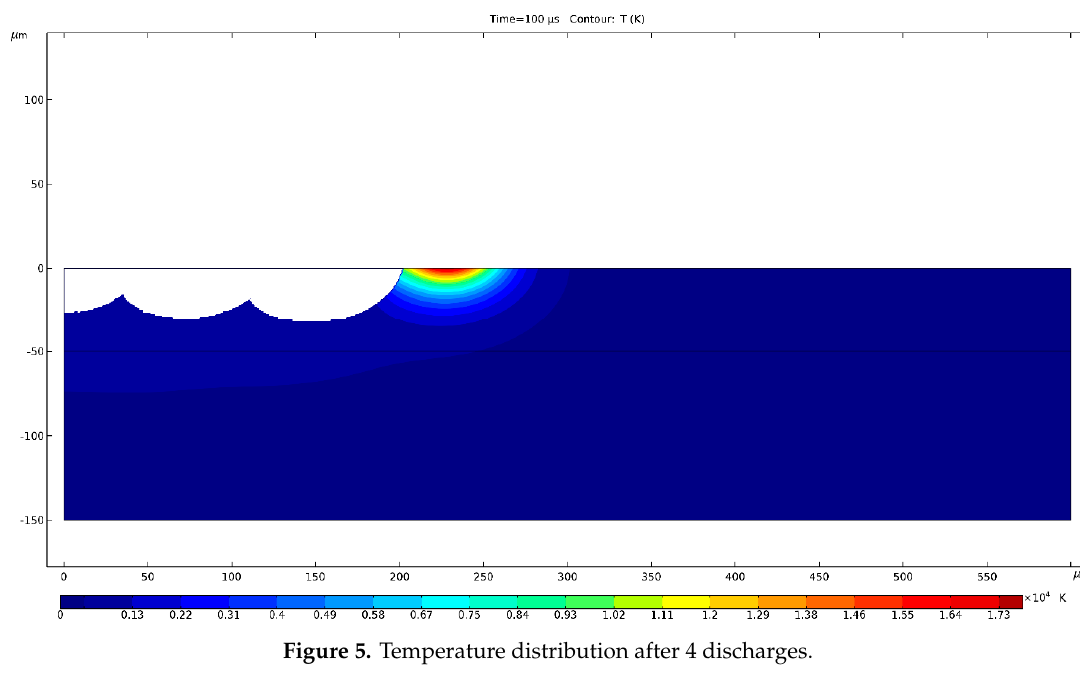
Figure 5. Temperature distribution after 4 discharges.